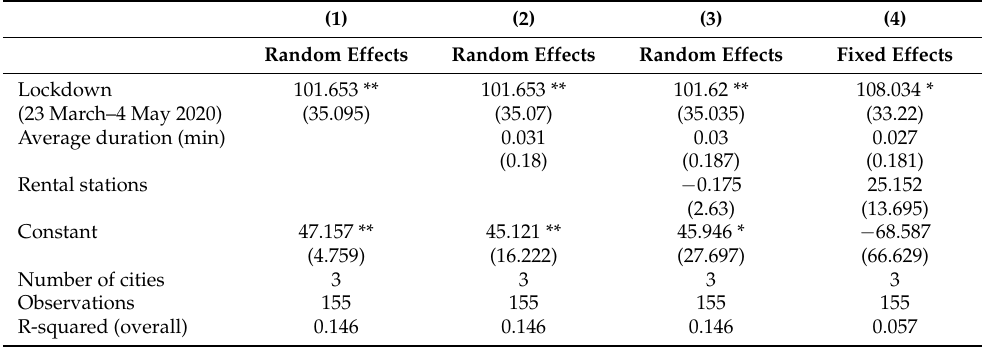
Table 8. The effect of lockdown on number of rides, comparing lockdown period and non-lockdown period, excluding rides with duration less than 5